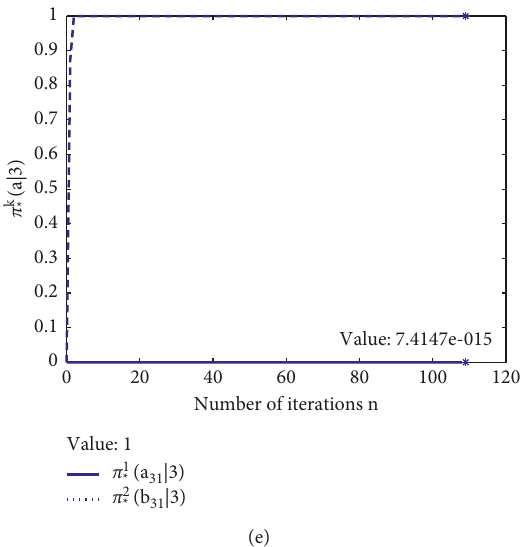
Figure 1: The case of varying discount factors with α ( 1 ) � 0 . 9 , α ( 2 ) � 0 . 85 , and α ( 3 ) � 0 . 95. (a) Error of iterative values. (b) Optimal values. (c) Optimal policy pairs in i � 1. (d) Optimal policy pairs in i � 2. (e) Optimal policy pairs in i �